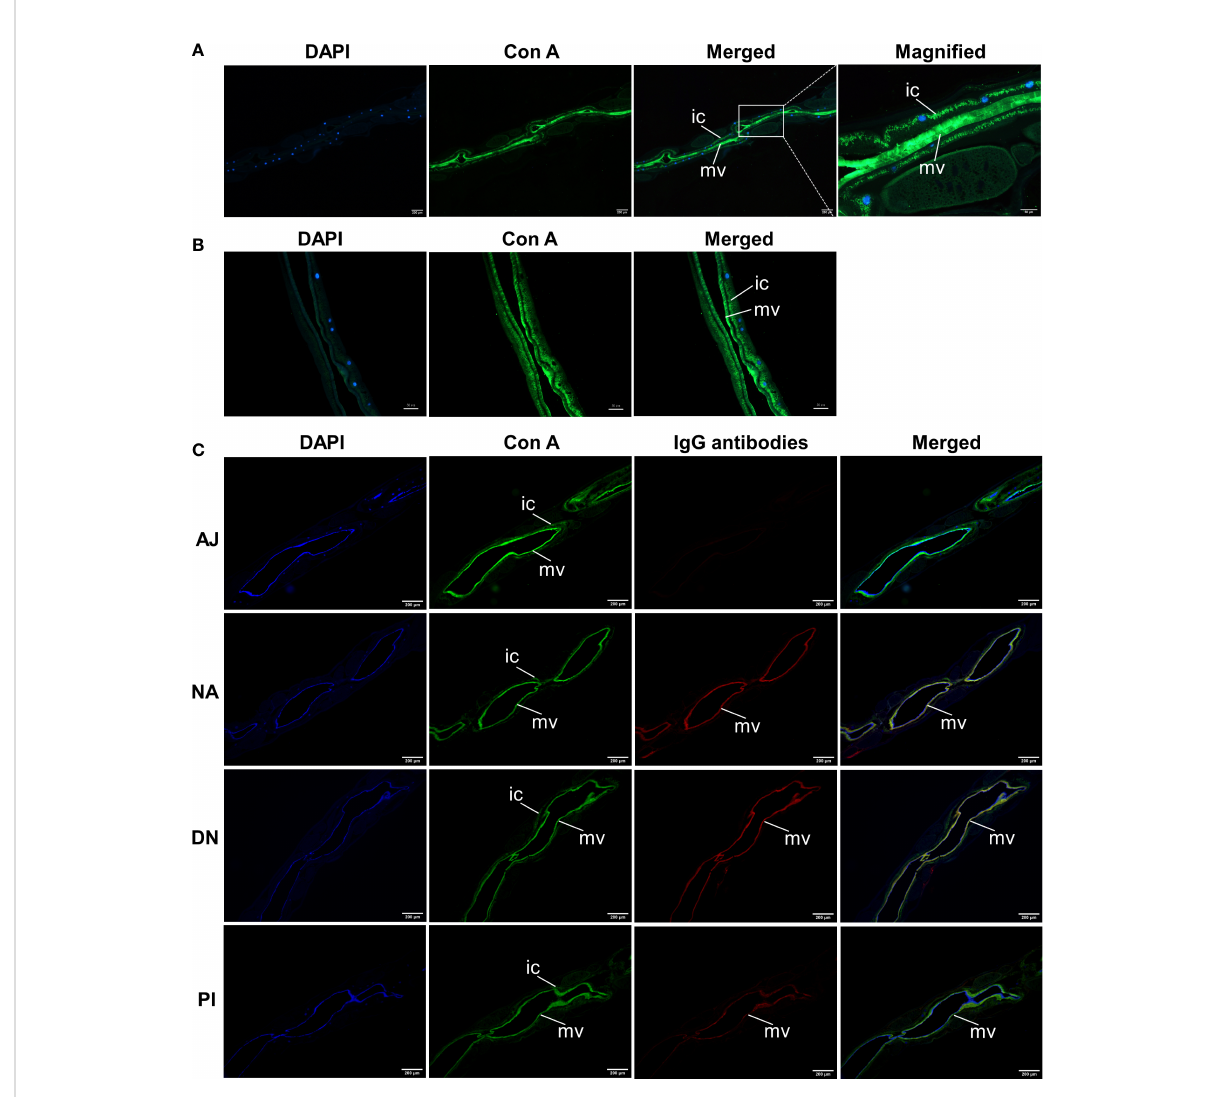
FIGURE 7 Anti-H11 IgG antibodies from immunoprotected goats bind glycoconjugates in the microvilli of Haemonchus contortus gut. (A, B) Lectin histochemistry analysis to determine the localisation of native H11 in adult H. contortus . Paraf fi n-embedded slides of adult worm (A) and isolated intestinal tissue (B) were probed with fl uorescein-labelled concanavalin A (Con A, green), and then stained with 4 ’ ,6-diamidino-2- phenylindole (DAPI, blue) to detect cell nuclei. Panel 1, DAPI; Panel 2, Con A; Panel 3, merged signals from DAPI and Con A; Panel 4, merged image magni fi ed from panel 3. (C) Lectin histochemistry and immunohistochemistry to determine the co-localisation of Con A and IgG antibodies bound native H11 in adult H. contortus. Slides of adult worms were incubated with fl uorescein-labelled Con A (green) and then with four IgG antibodies puri fi ed from pooled sera samples (collected on day 42 of the immunisation trial, cf. Figure 4A) from individual animal groups (AJ, NA, DN or PI). Washing samples were incubated with Cy3-conjugated donkey anti-goat IgG (red) and then stained with DAPI (blue). Panel 1, DAPI; Panel 2, Con A; Panel 3, individual IgG antibodies; Panel 4, merged signals from DAPI, Con A and individual IgG antibodies. Scale bars: A = 50 µm or 200 µm; B = 50 µm; C = 200 µm. (ic = intestinal cytoplasm; mv = microvilli). The images shown here were derived from two independent